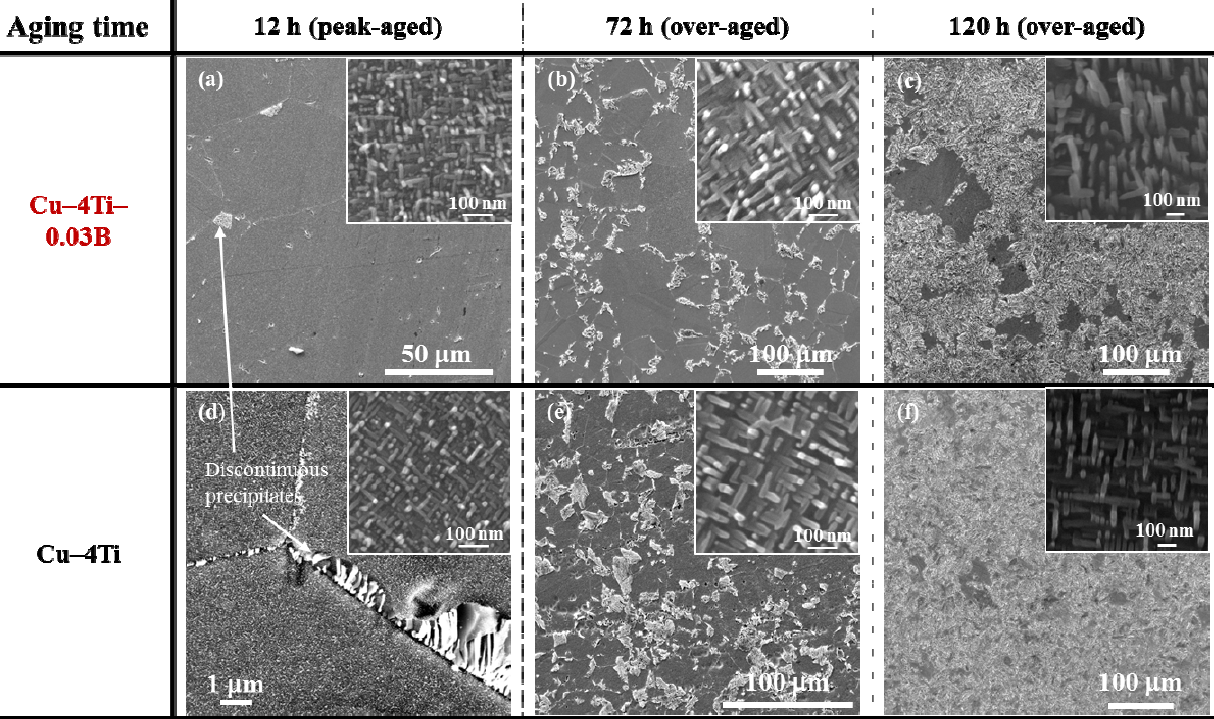
Figure 2. FE-SEM images of Cu–4Ti–0.03B and Cu–4Ti alloys that were aged at 450 °C for 12, 72, and 120 h. The insets are higher-magnification FE-SEM images, which focus on the continuous